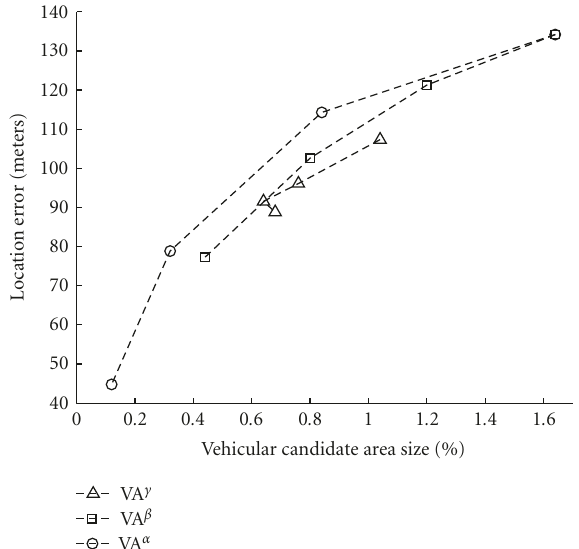
Figure 9: Location error for vehicular candidate area size.